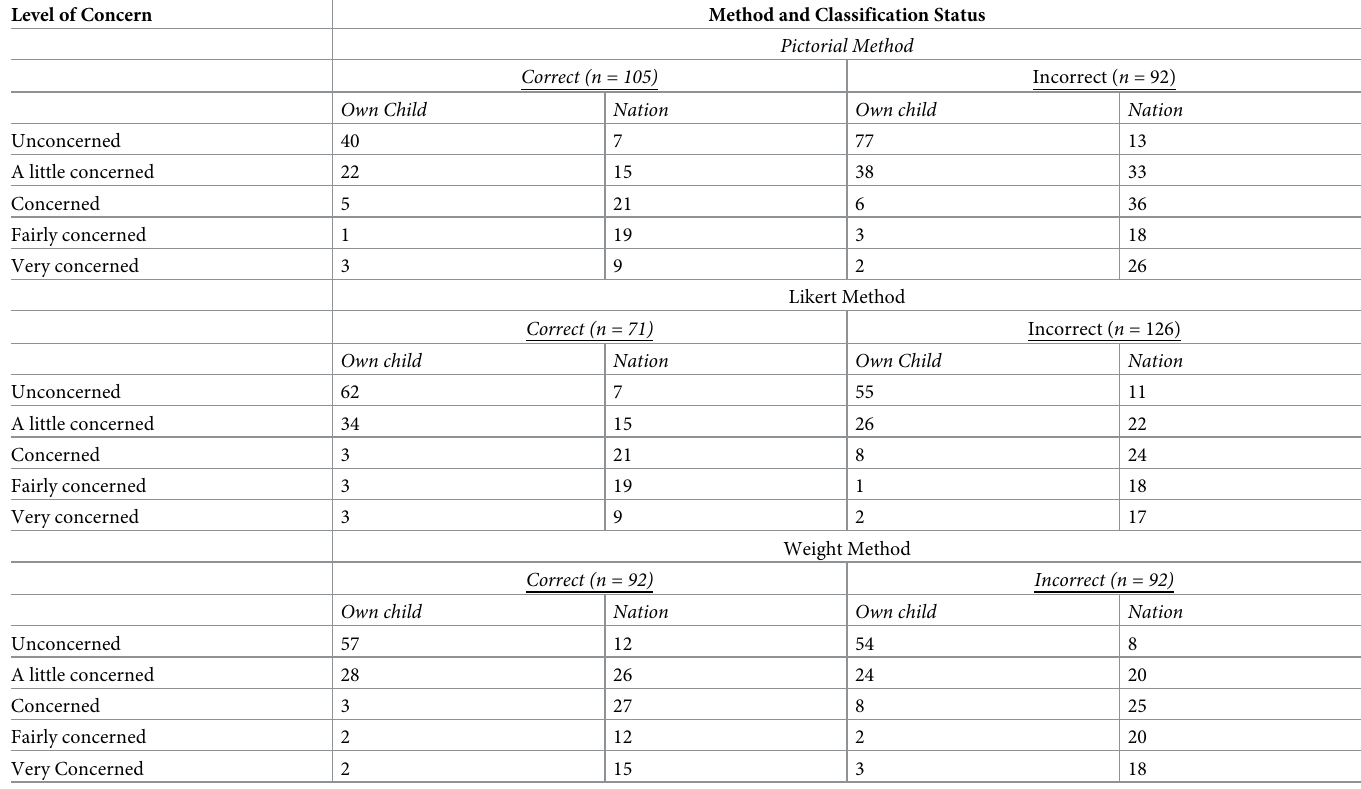
Table 5. Comparison of concern of weight of own child versus national weight of children by classification